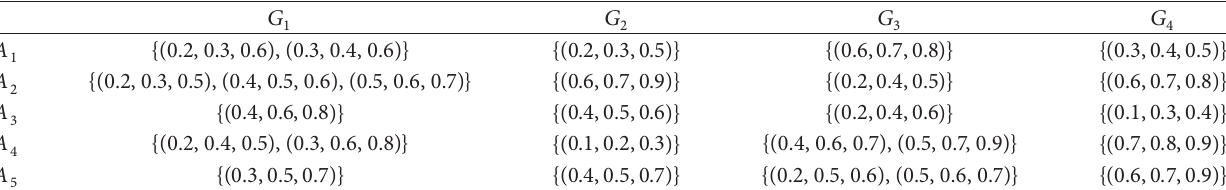
Table 1: Hesitant triangular fuzzy decision matrix 𝐻